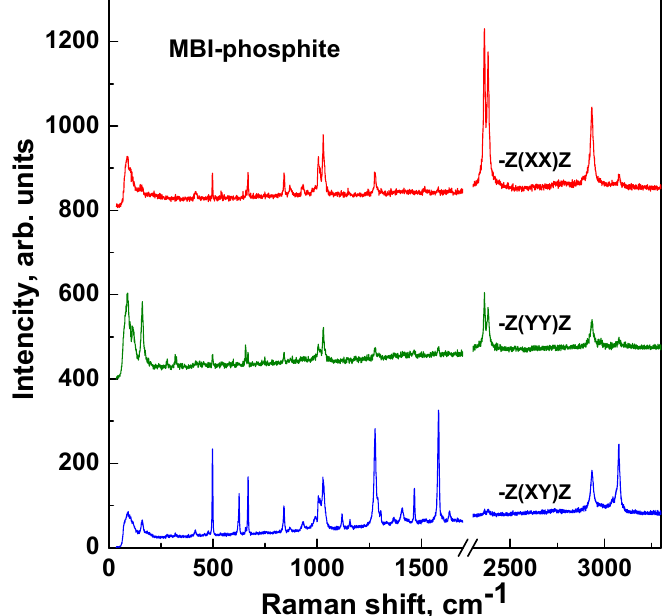
Figure 9. Raman spectra of MBI-phosphite crystal for different experimental geometries. Table 3. Lines observed in MBI-phosphite polarized Raman spectra. Abbreviations: vs – very strong, s – strong, m – medium, w – weak, b – broad, Γ – out-of-plane bending, δ – in-plane bending, ν –